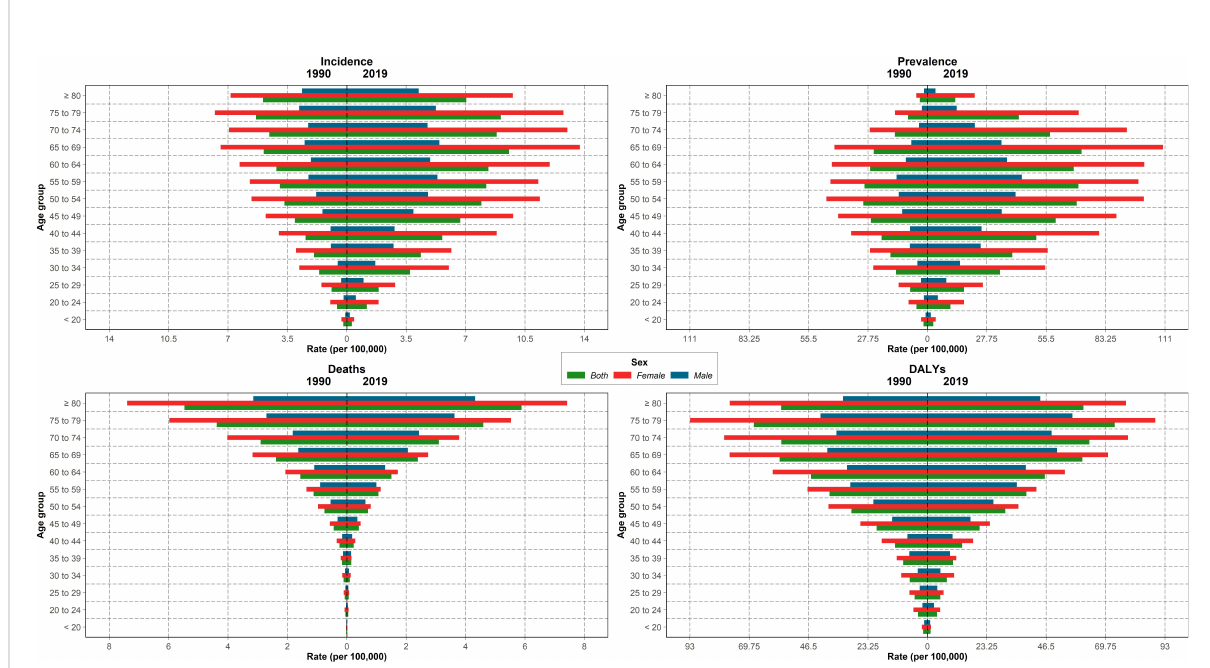
FIGURE 3 Incidence, prevalence, death, and disability-adjusted life year (DALY) rate of thyroid cancer in North Africa and Middle East regions in 1990 and 2019, by sex and